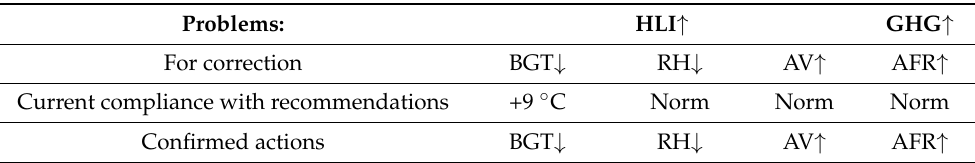
Table 9. Determining factors for change in the 21.00 time case.